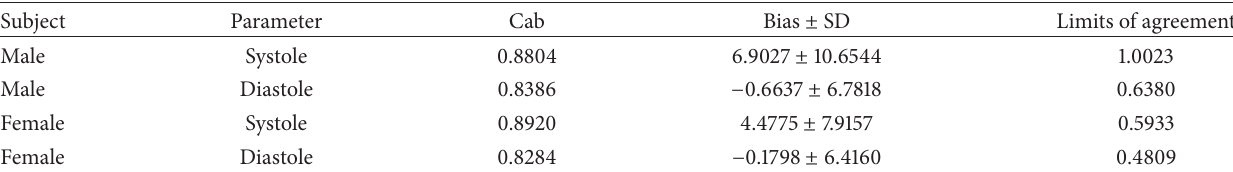
Table 2: Correlation study and Bland-Altman analysis results for device